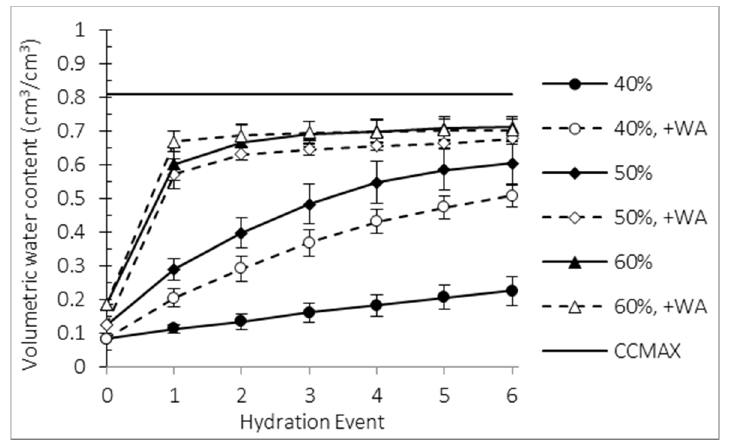
Figure 2. Hydration curves for peat with wetting agent (+WA) or without wetting agent according to initial moisture contents (40, 50, 60% w / w ); CCMAX = Container Capacity at 60% w / w initial Moisture Content ( w / w ).